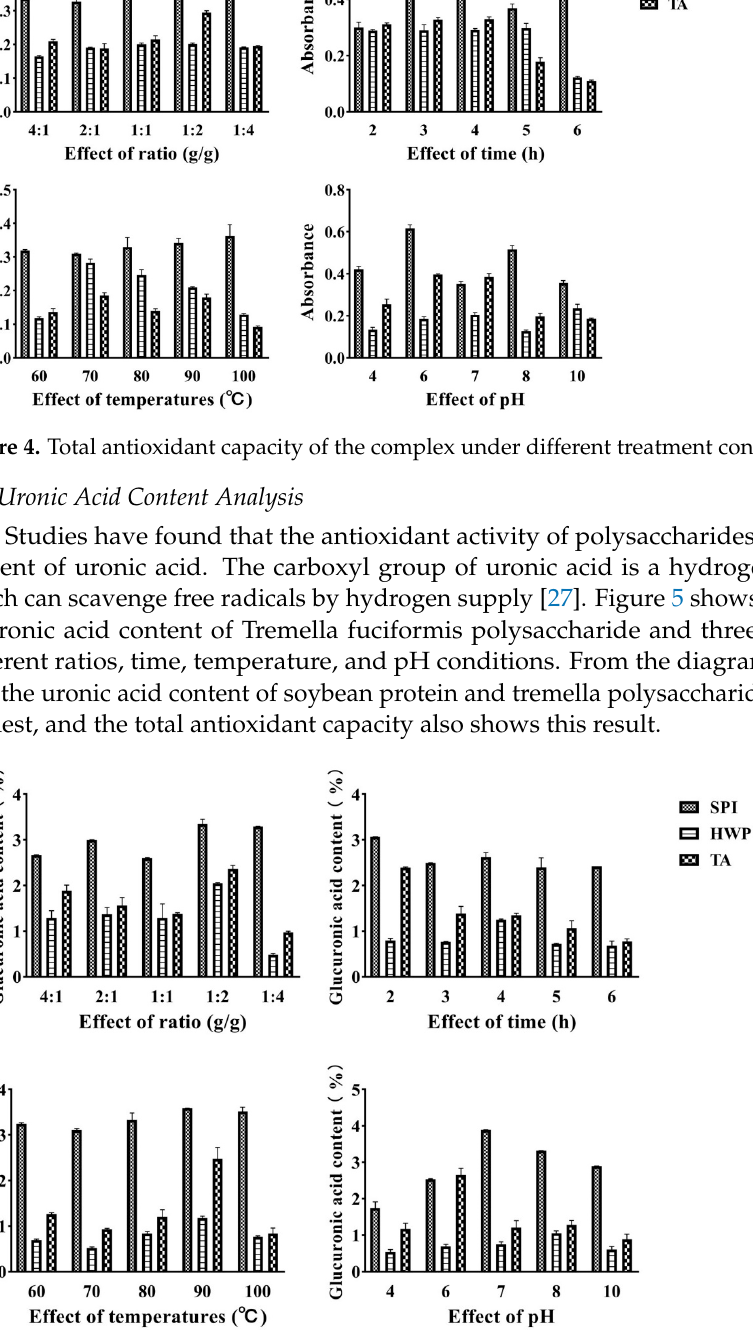
Figure 3. Hydroxyl radical scavenging ability of the complex under di ff erent treatment conditions.